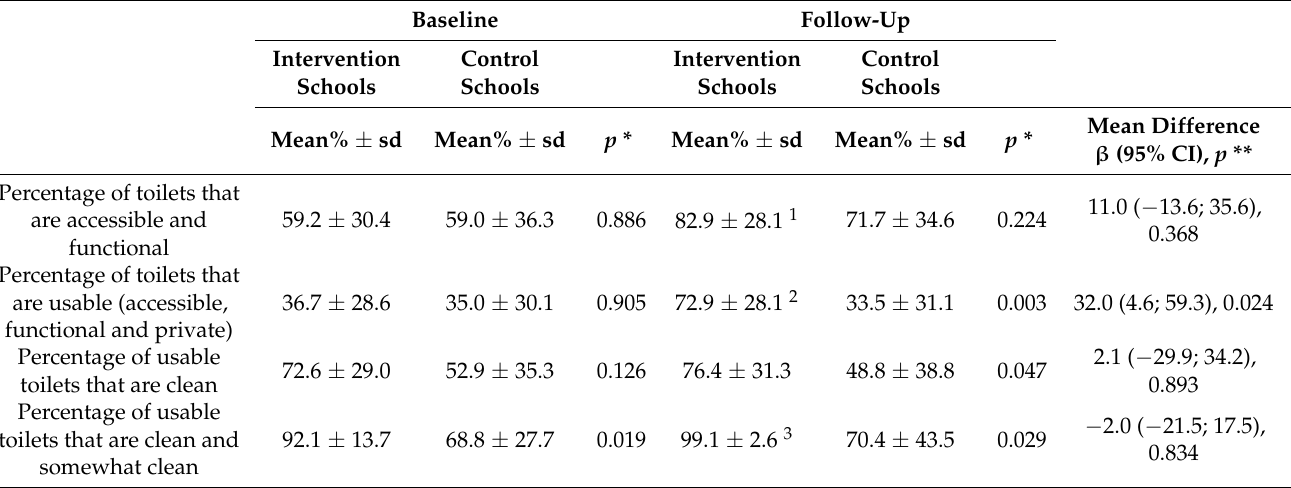
Table 2. Percentage of toilets meeting the SAT criteria in intervention and control schools at baseline and